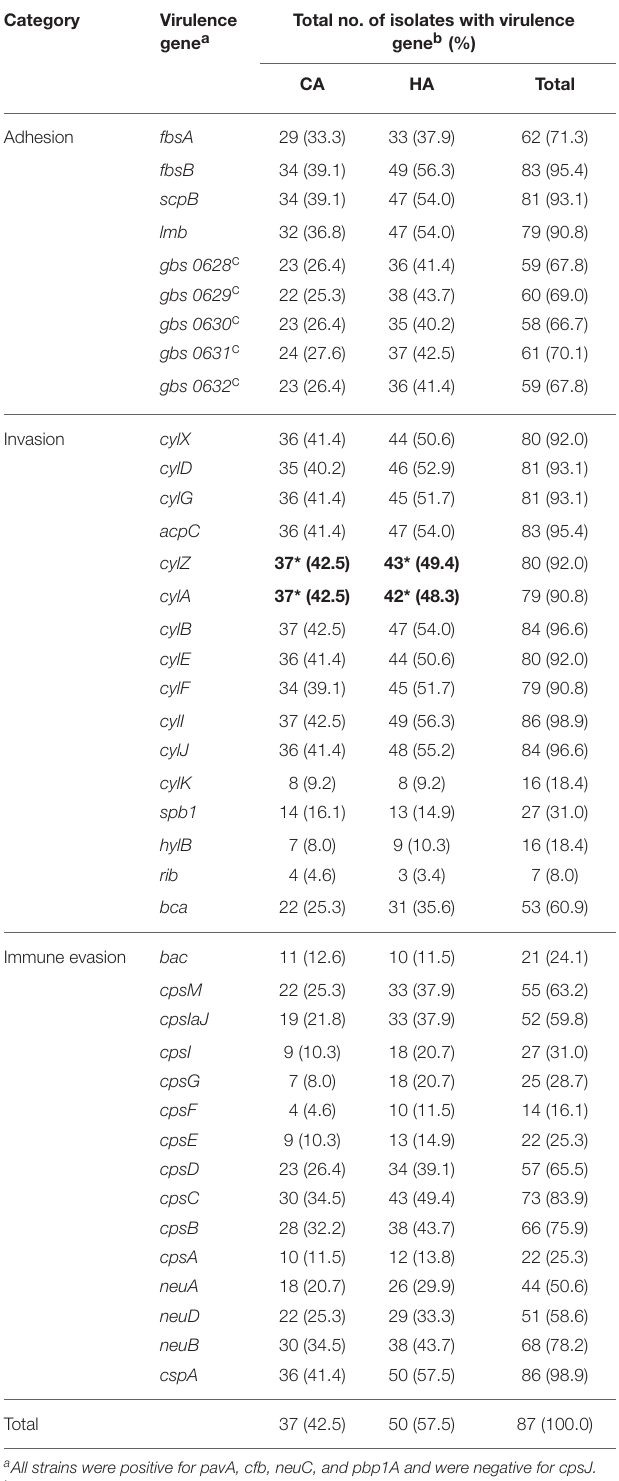
TABLE 2 | Distribution of virulence genes encoding particular proteins between CA-GBS and